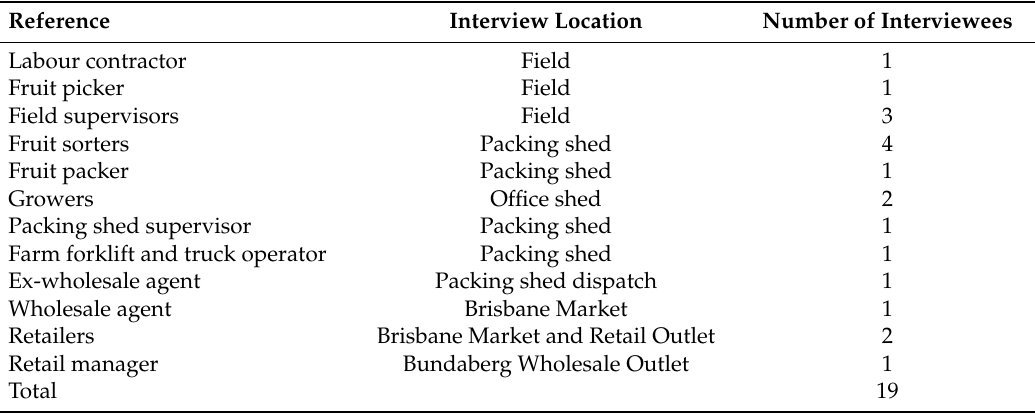
Table 1. Informal interviews—list of supply chain actors